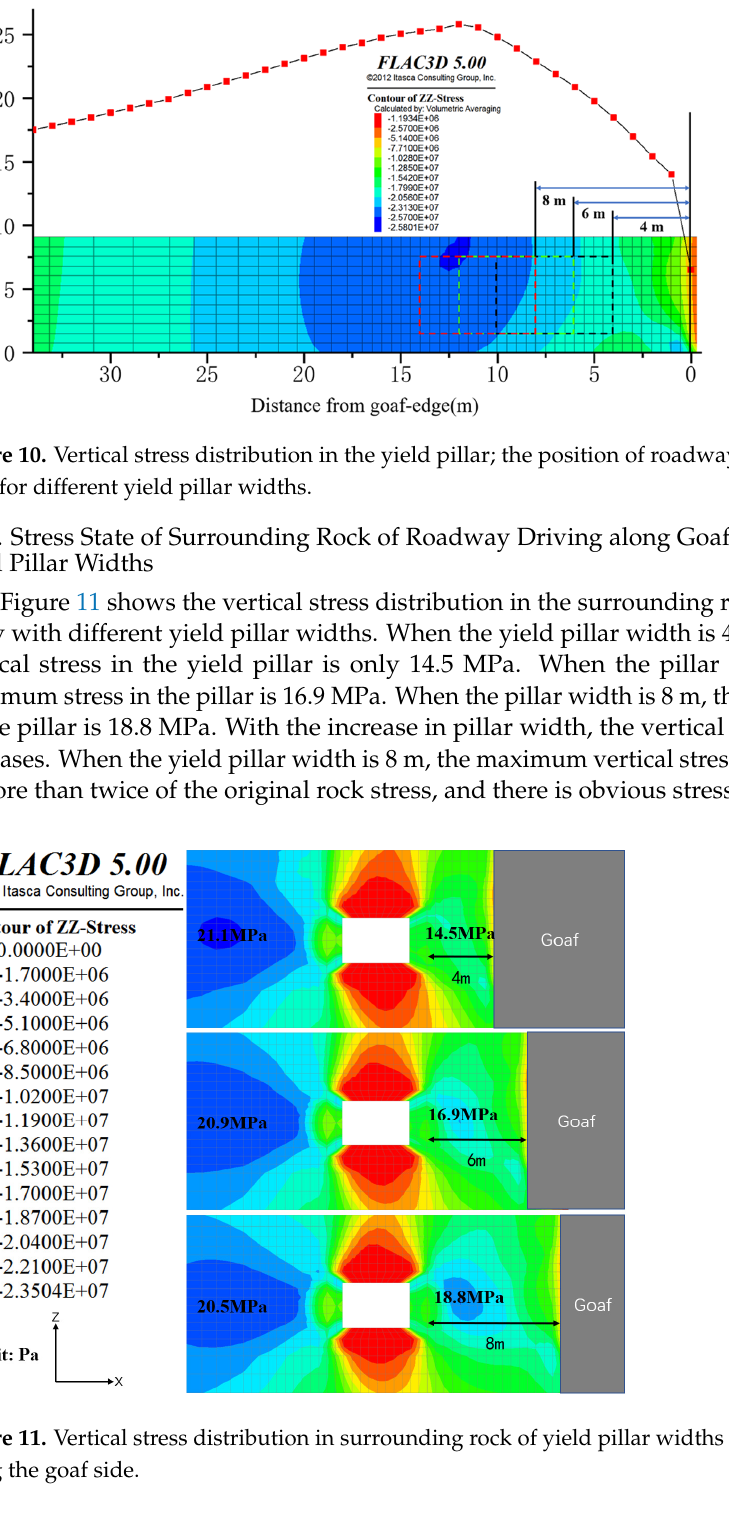
m along the goaf side. along the goaf